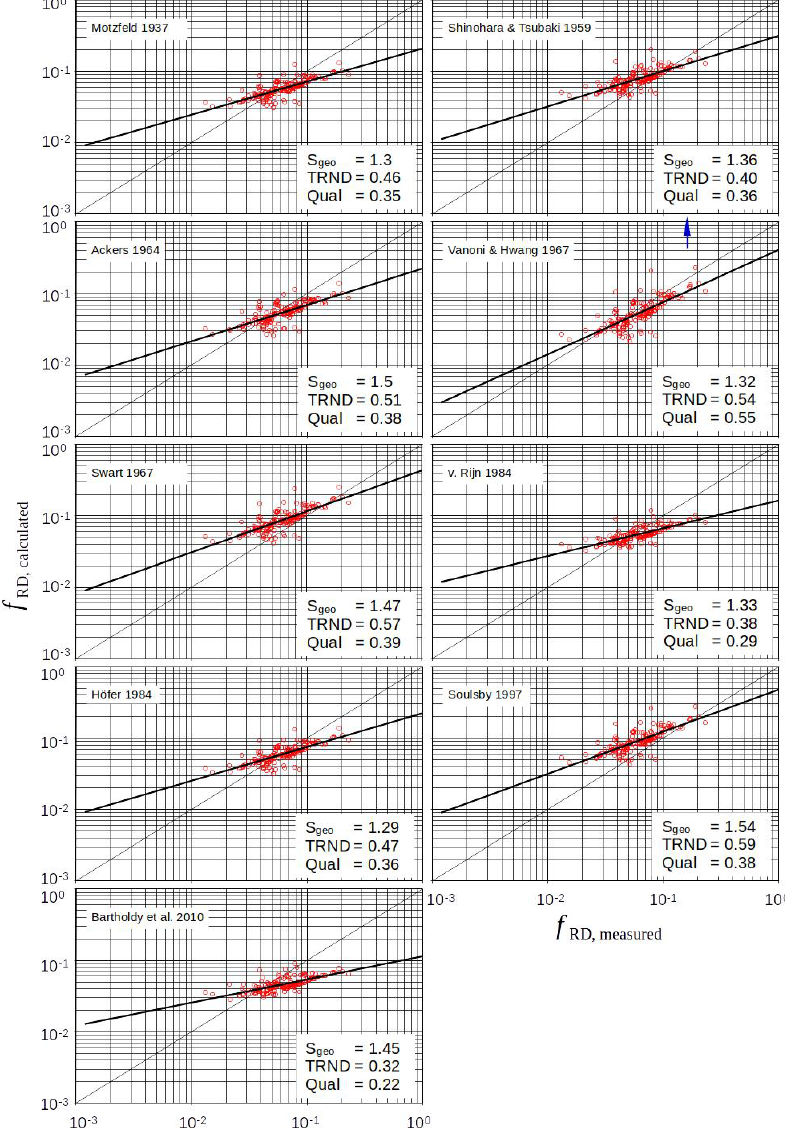
Figure 5. Approaches via the log profile f RD = 8 ( v / v (cid:63) ) − 2 and Equation (8) in the case of